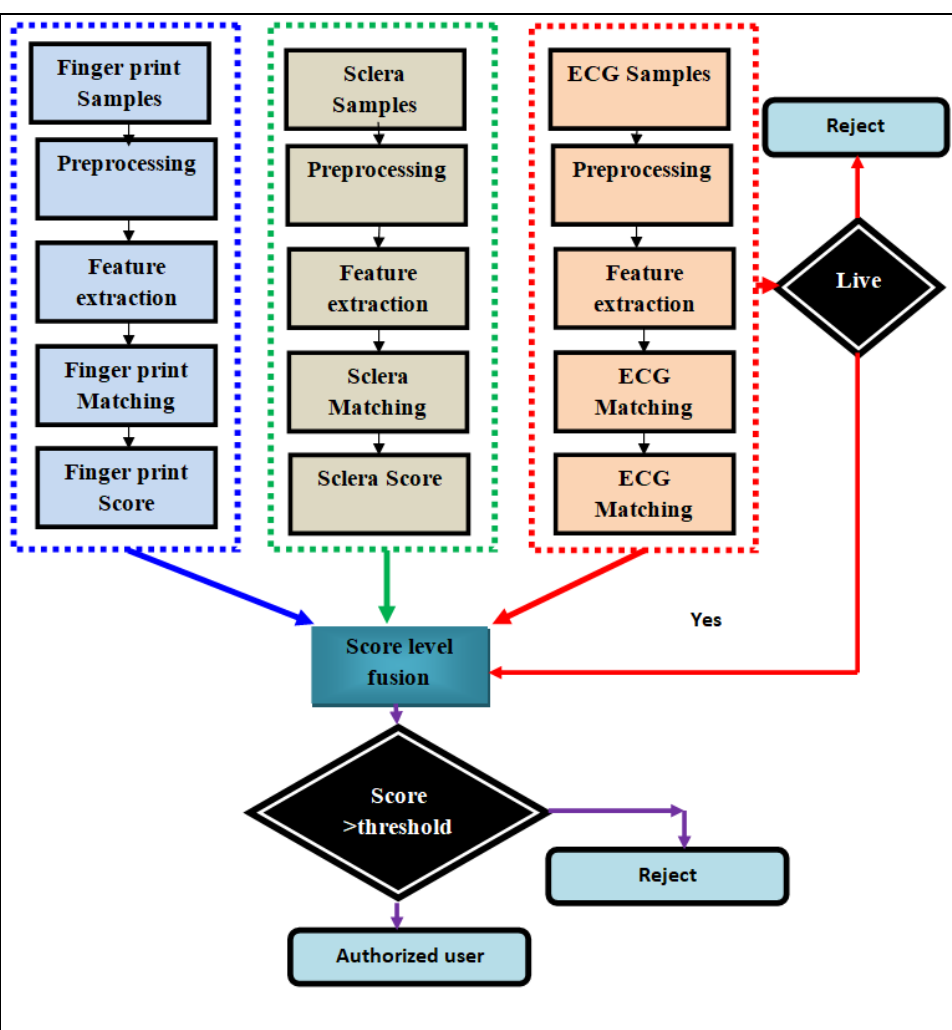
Figure 1. Parallel modal architecture.